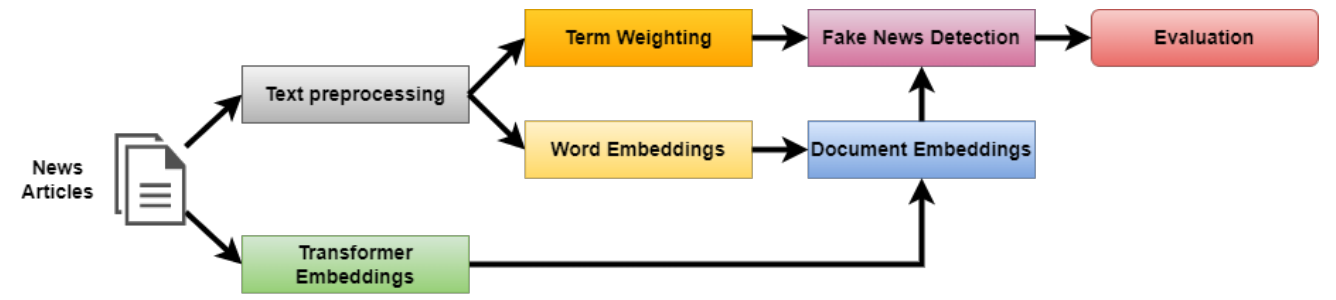
Figure 1. Proposed